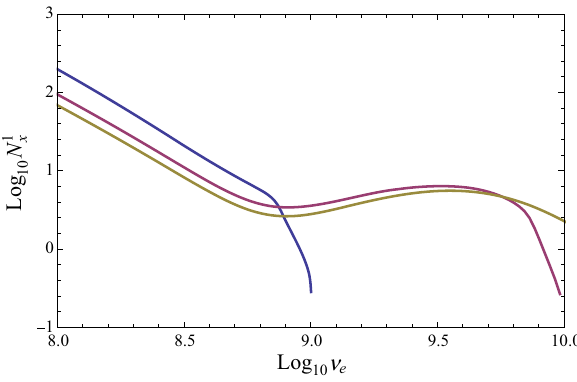
Fig. 3 The transverse PPF N 1 x | x = 0 . 035m generated by the SGWB with high frequency band 10 8 –10 10 Hz. The blue curve, the purple curve, and the brown curve correspond to the mergers of black hole bina- ries with various chirp masses, M c = 10 − 5 M (cid:2) , 10 − 6 M (cid:2) , 10 − 7 M (cid:2) ,